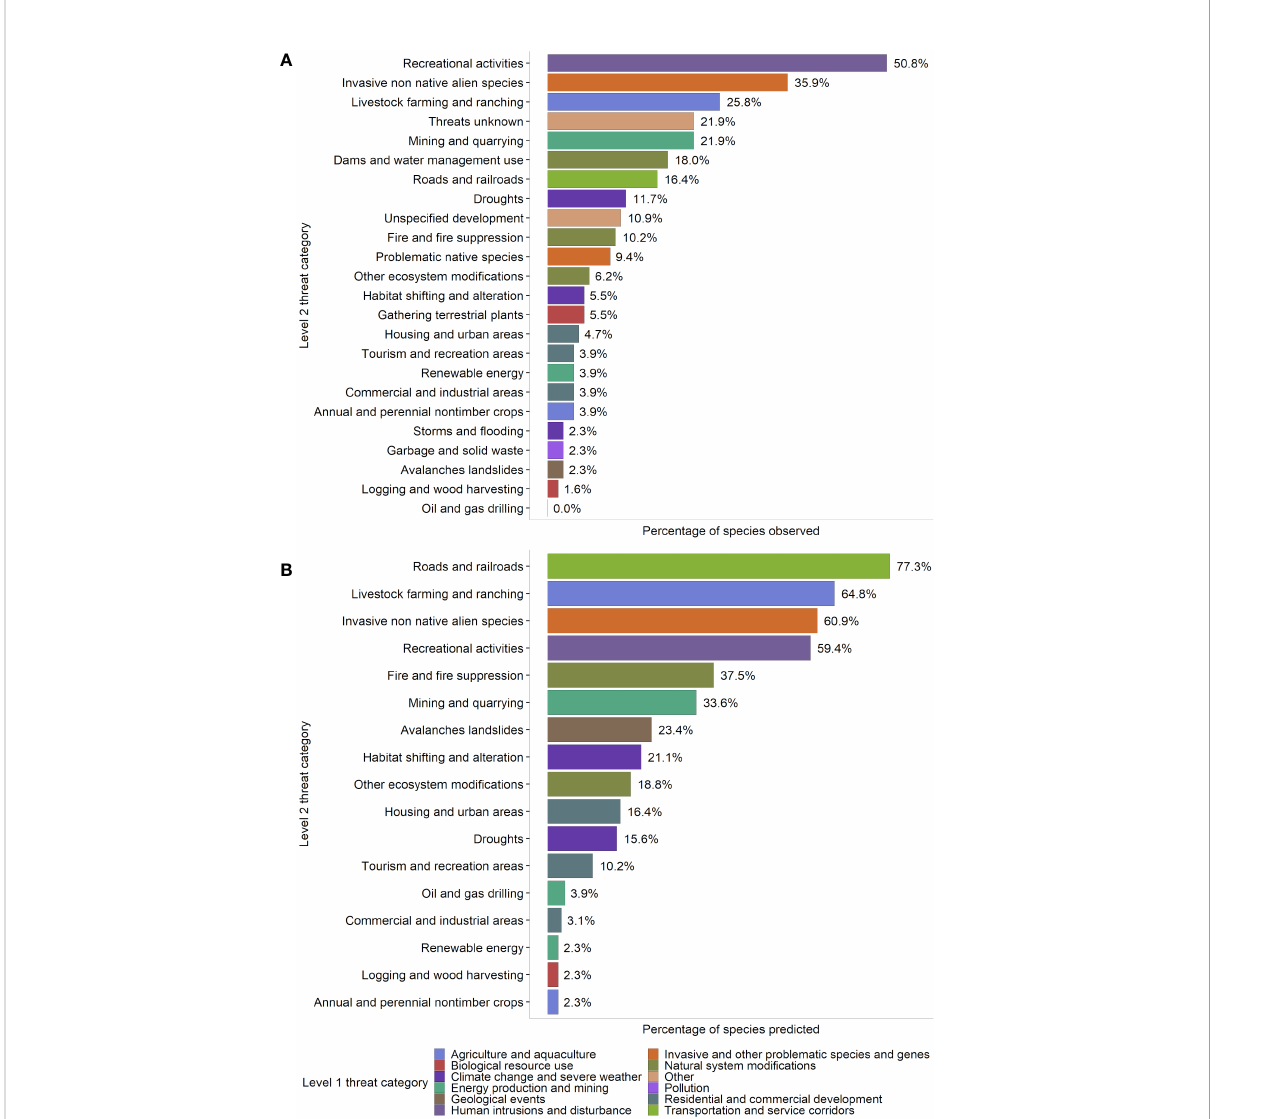
FIGURE 3 Percentage of 128 rare critically imperiled and imperiled (state conservation status rank S1 and S2) plant species found in Nevada that were either (A) observed or (B) predicted by geospatial data to be affected by various threats. This fi gure is presented in a similar format to Hernandez-Yanez 2016, a US-wide assessment, to allow for direct comparison. Data included our fi eld observations, survey data from the Nevada Division of Natural Heritage, and literature review; threats were counted as “ present ” for a species if noted for at least one occurrence during surveys. Threats were classi fi ed using the IUCN-CMP Classi fi cation of Threats framework used by NatureServe (Salafsky et al., 2008), which is comprised of 11 broad threat categories ( “ level 1 ” ; L1), each with 3-6 more speci fi c sub-categories ( “ level 2 ” ; L2) (Appendix 2). Notes: 1) The percentage of species threatened does not necessarily indicate the severity of the threat to the species affected by each stressor; e.g., less prevalent habitat-converting threats such as residential and commercial development and mining could result in more rapid population declines and/or local extirpation for species affected than more prevalent but potentially less severe habitat-degrading threats such as recreation, invasion, livestock, and roads. 2) See the Discussion for a more detailed analysis of discrepancies between observed and predicted threats in panels (A, B)